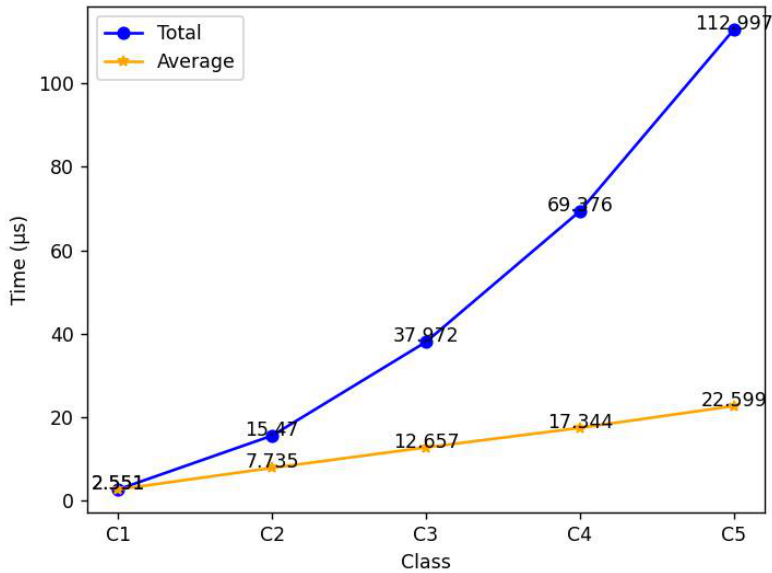
Figure 10. The average time for calculating the decryption key.